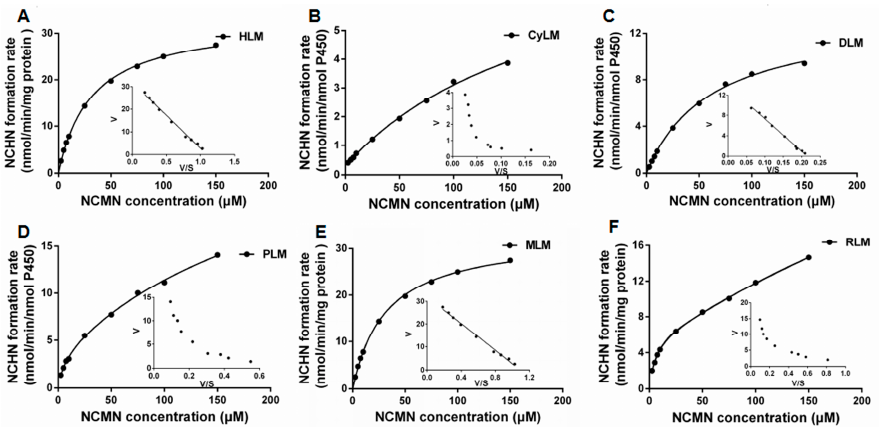
Figure 5. Enzymatic kinetic plots of NCMN -O- demethylation in liver microsomes from human ( A ), cynomolgus monkey ( B ), beagle dog ( C ), minipig ( D ), mouse ( E ) and rat ( F ). NCMN (1–150 µ M) was incubated with HLM, CyLM, DLM, PLM, MLM or RLM(F) at 37 ◦ C. Please add explanations for (A)-(F) Table 2. Kinetic parameters of NCMN -O- demethylation in liver microsomes from different species. Enzyme source V m1 V m2 K m1 K m2 V m / K m HLM 25.61 ± 0.15 9.54 ± 0.24 2684.48 CyLM 8.43 ± 0.91 0.28±0.08 198.70 ± 39.66 0.18 ± 0.09 1559.45 1 DLM 13.53 ± 0.34 61.79 ± 3.52 218.96 PLM 28.22 ± 5.82 3.35 ± 1.20 242.80 ± 111.80 5.70 ± 3.27 587.44 1 MLM 33.17 ± 0.42 22.80 ± 1.22 1454.82 RLM 78.42 ± 31.17 5.71 ± 0.45 1134.00 ± 482.10 5.66 ± 0.80 1007.94 1 K m values are in µM; V m values are in nmol/min/mg for liver microsomes; V m /K m values are in ml/min/mg for liver microsomes. The range of substrate concentrations was 1–150 µM. 1 V m /K m values were calculated by using the lower V m and K m values.